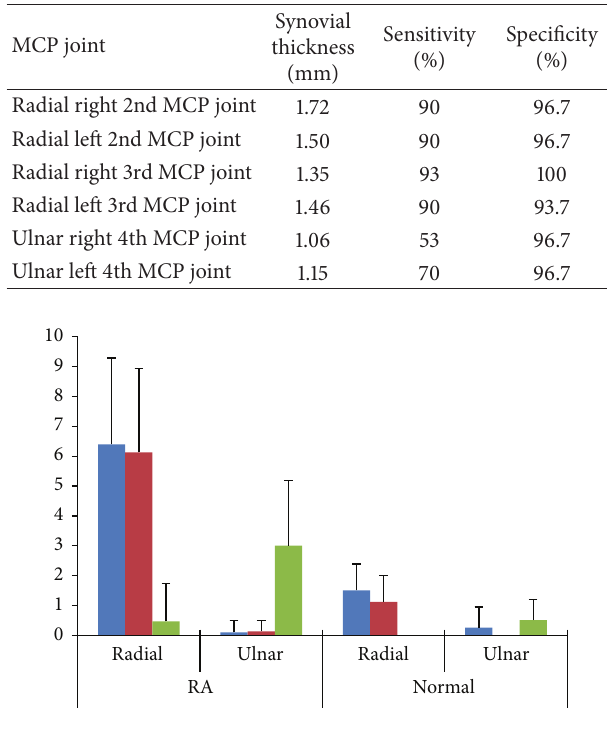
Table 1: Optimal cut-offs to distinguish between the synovial thickness of the healthy and pathological joints.